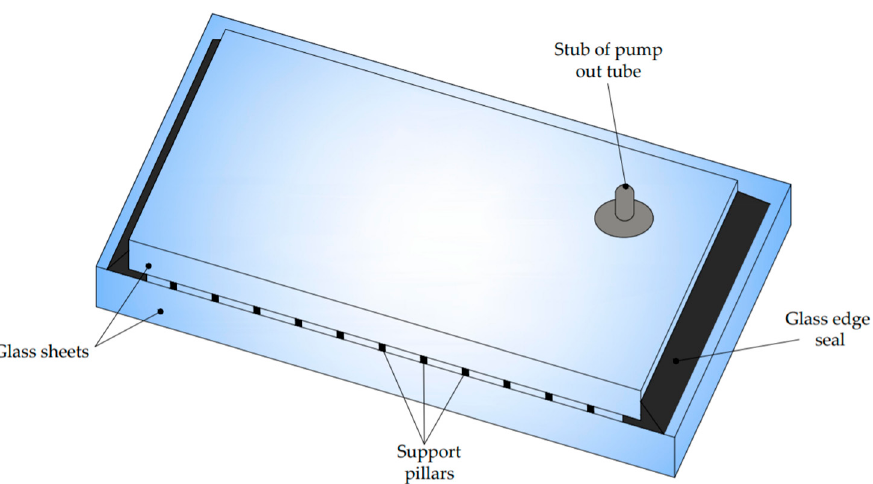
Figure 2. Scheme of construction of the VIG